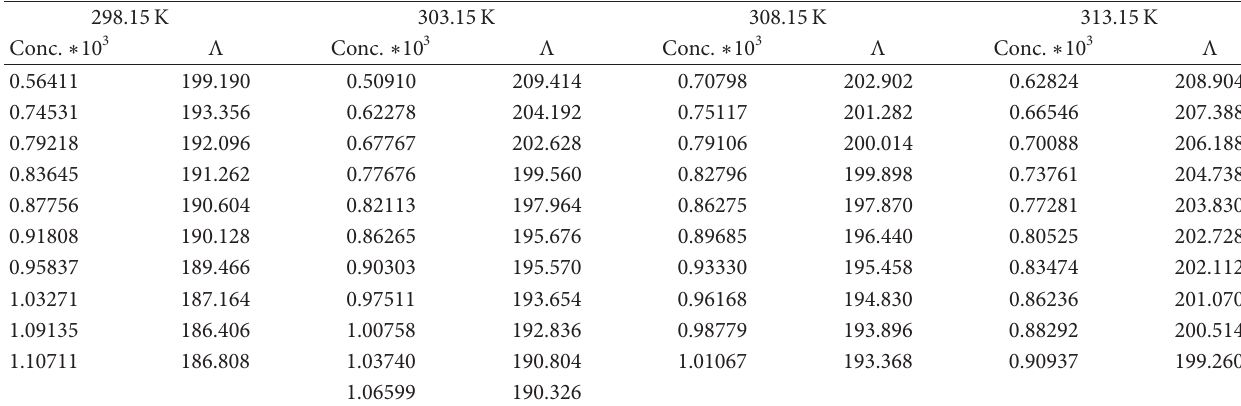
T 1: Experimental conductance data for Ba succinate.